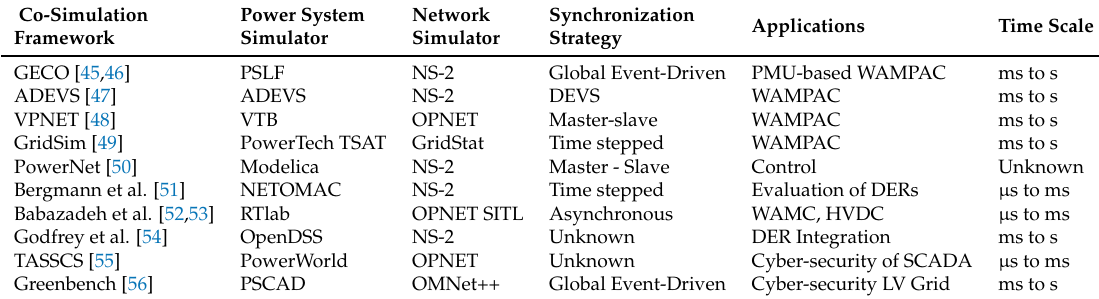
Table 2. Some co-simulation frameworks using ad-hoc connections in the domain of CPES.